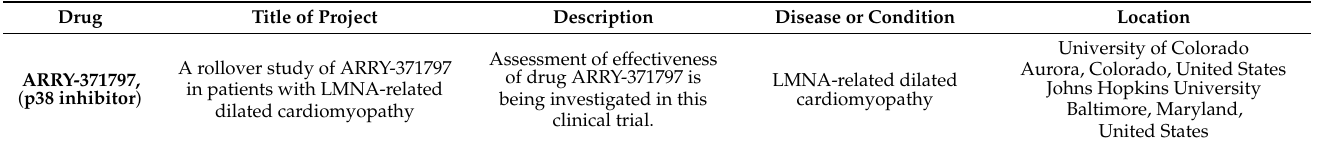
Table 5. Description of drugs for dilated cardiomyopathy undergoing clinical trials in the United States